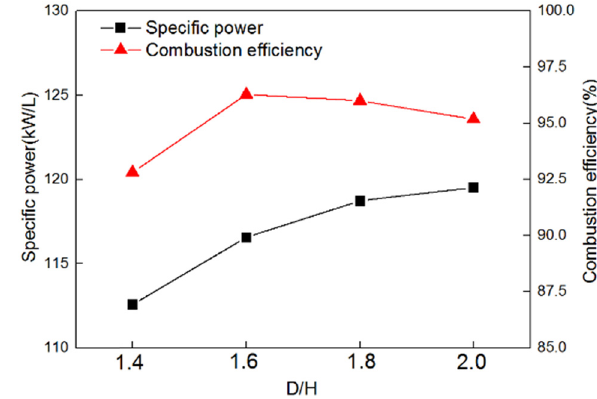
Figure 16: The mean TKE and STD of equivalence ratio for di ff erent diameter - to - depth ratios.